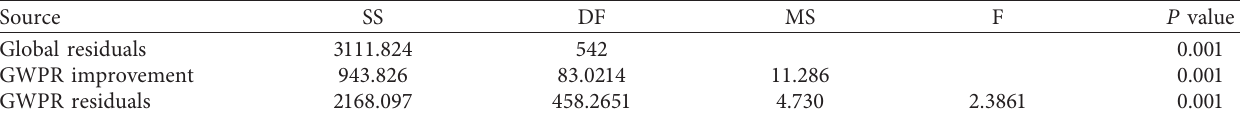
Table 9: ANOVA table for GWPR